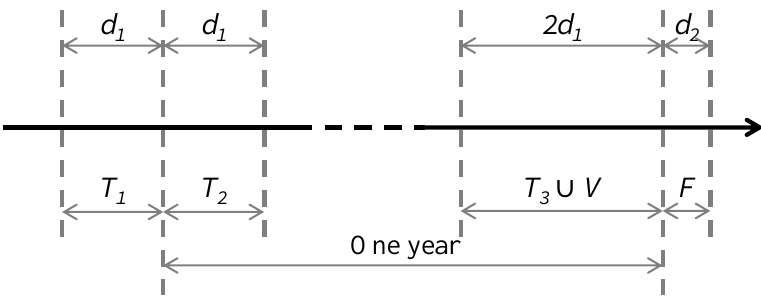
Figure 2. Training, validation, and test/forecast periods arrangement.